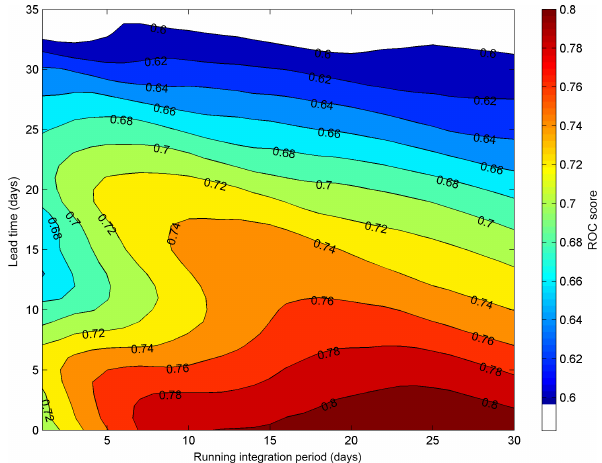
Figure 8. ROC score diagram of AWS-based prediction. The white color masks nonsignificant regions, where ROC scores are below the 95% confidence